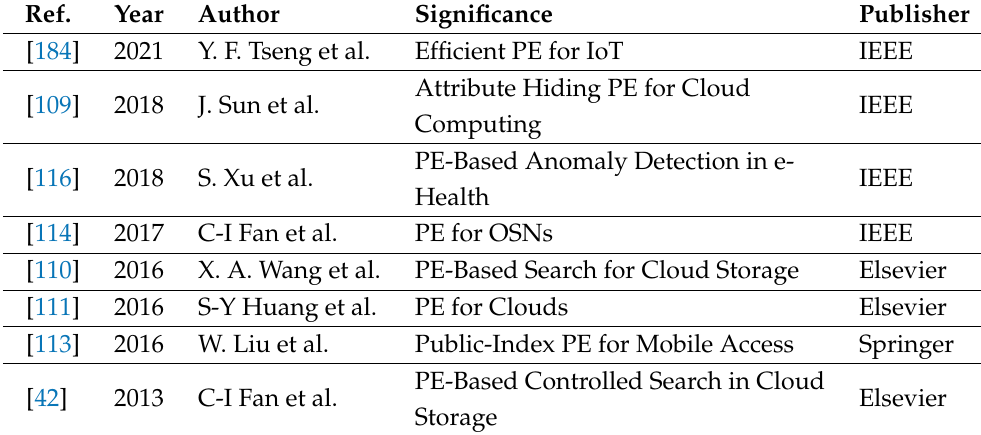
Table 5. Significant IoT-related literature for PE in the last decade.